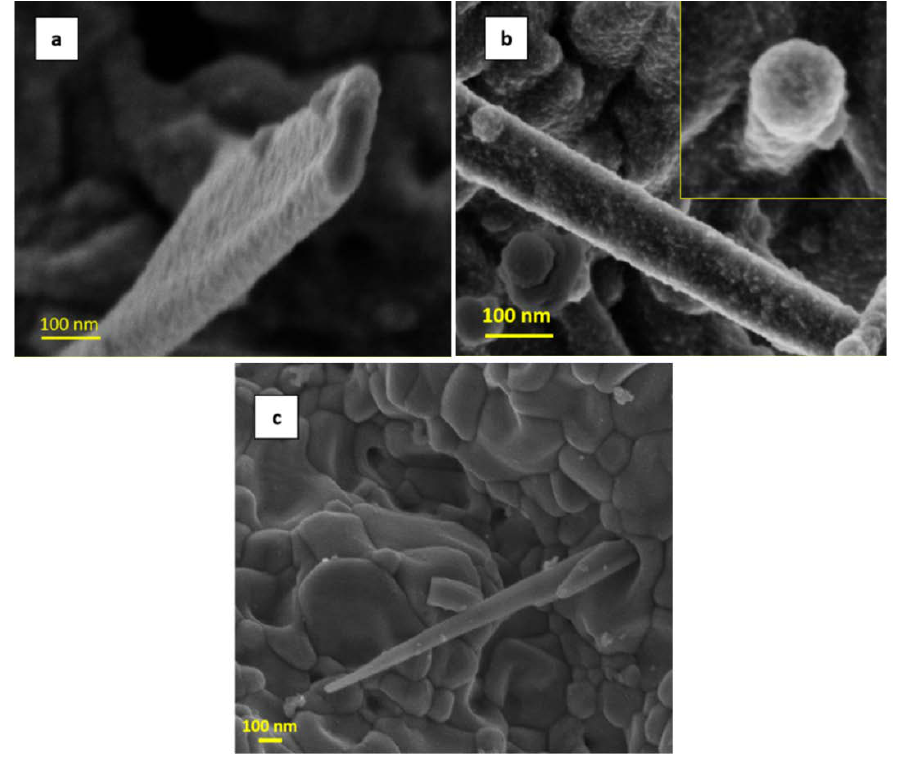
Figure 3. High-resolution SEM micrographs: ( a ) sample A, ( b ) sample B-Sn, and ( c ) sample C-Mg.